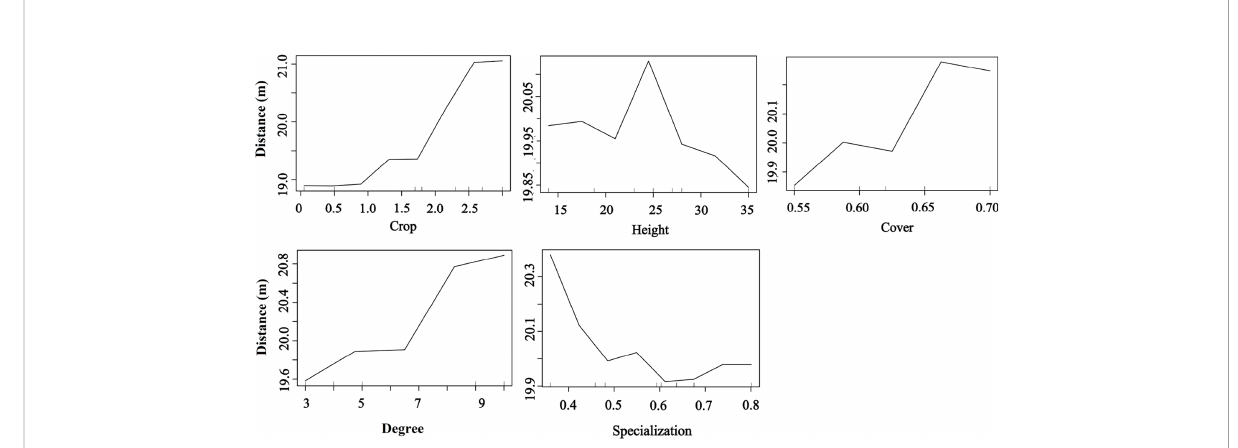
FIGURE 7 Effects of plant traits and two network metrics on the dispersal distance representing a fragmented forest in Southeast China. Results were determined using the Random Forest algorithm and showed the partial effects of independent variables on dispersal